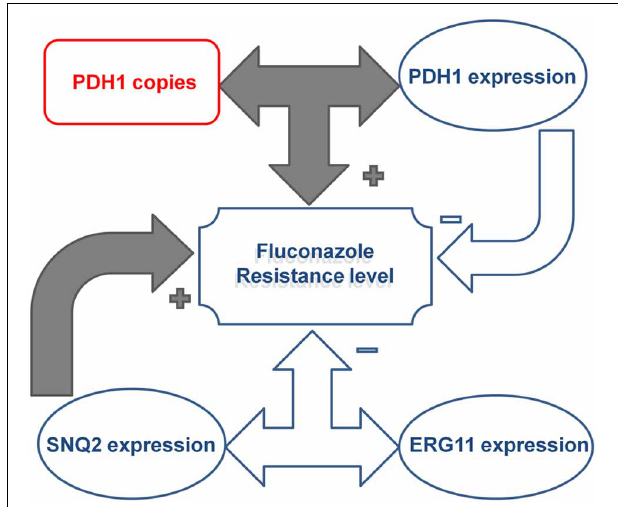
FIGURE 1 | Illustration of the effect of the complex interactions between CgPDH1 , CgSNQ2 , and CgERG11 drug resistance gene copy numbers and expression levels on fluconazole resistance in Candida glabrata clinical isolates. CgPDH1 gene copy number and expression were correlated, and their interaction led to an increase in fluconazole MIC levels. In contrast, the main effect of CgPDH1